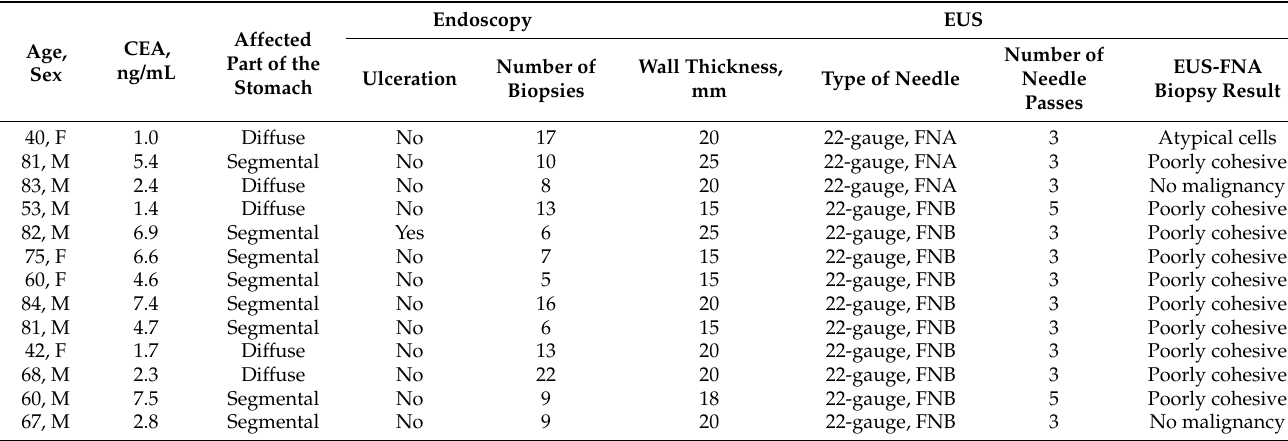
Table 2. Characteristics and outcomes of patients with GLP who underwent EUS-guided fine-needle aspiration biopsy following negative endoscopic biopsy ( n = 13).